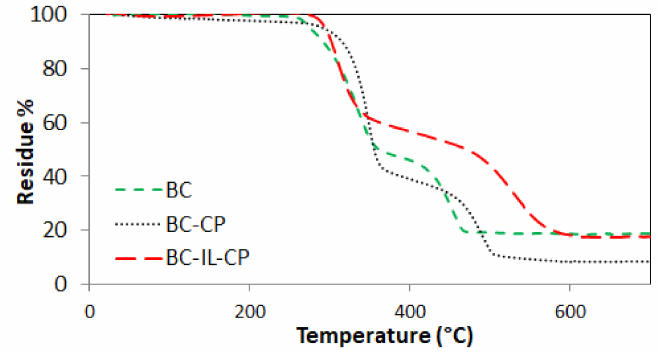
Figure 9. TGA curves of BC, BC-CP, and